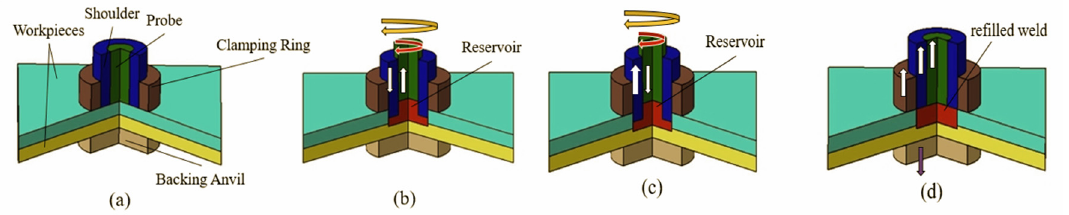
Figure 1. Schematic representation of refill FSSW procedure: ( a ) step 1—initiation; ( b ) step 2—shoulder plunging; ( c ) step 3—refilling; ( d ) step 4—finishing.